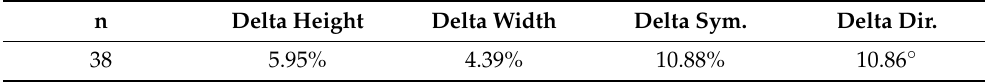
Table 4. Comparison of the manual and automated metrics over Point Cloates